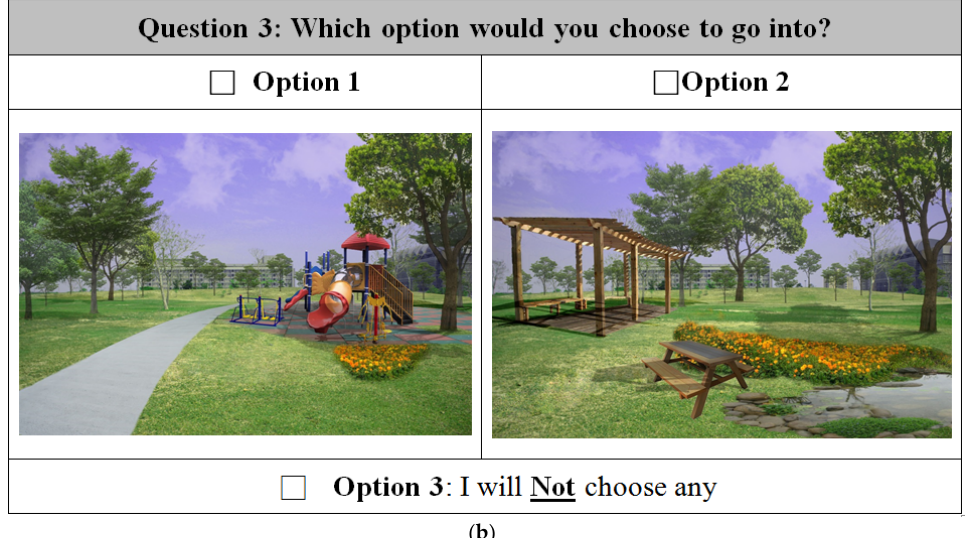
Figure 2 . ( a , b ) Examples of a choice set in the experiment. Figure 2. ( a , b ) Examples of a choice set in the